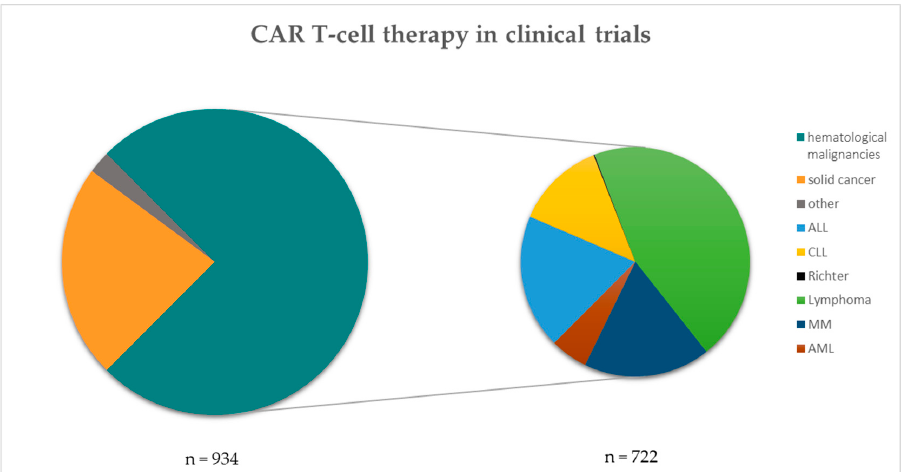
Figure 1. CAR T-cell therapy in clinical trials. The left pie chart shows the number (n) of CAR T-cell therapies in clinical trials categorized into solid cancers, others and hematological malignancies (n = 934). The hematological malignancies are further listed within the right pie chart (n = 722). Data taken from clinicaltrials.gov and filtered for each disease separately [13]. Search criterion was “CAR” and all hits were manually filtered for each category